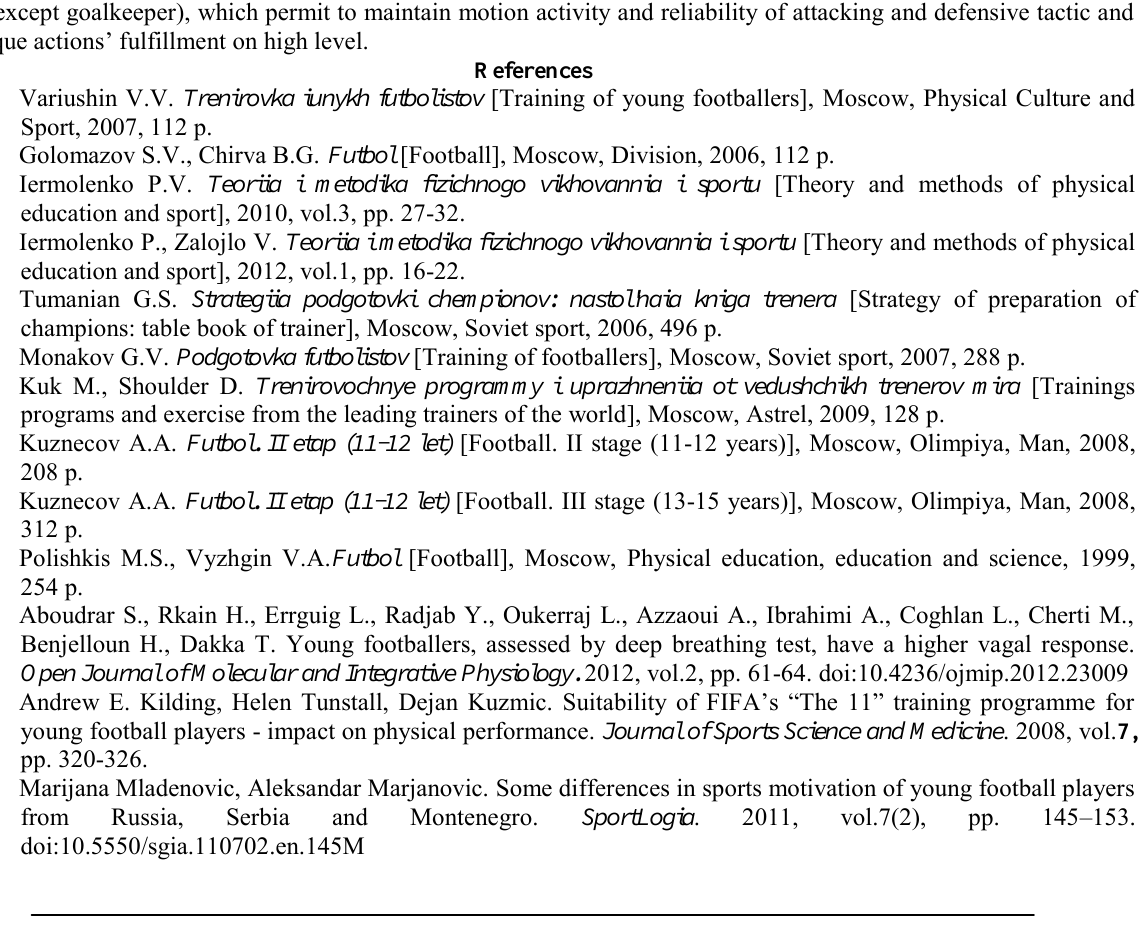
champions: table book of trainer], Moscow, Soviet sport, 2006, 496